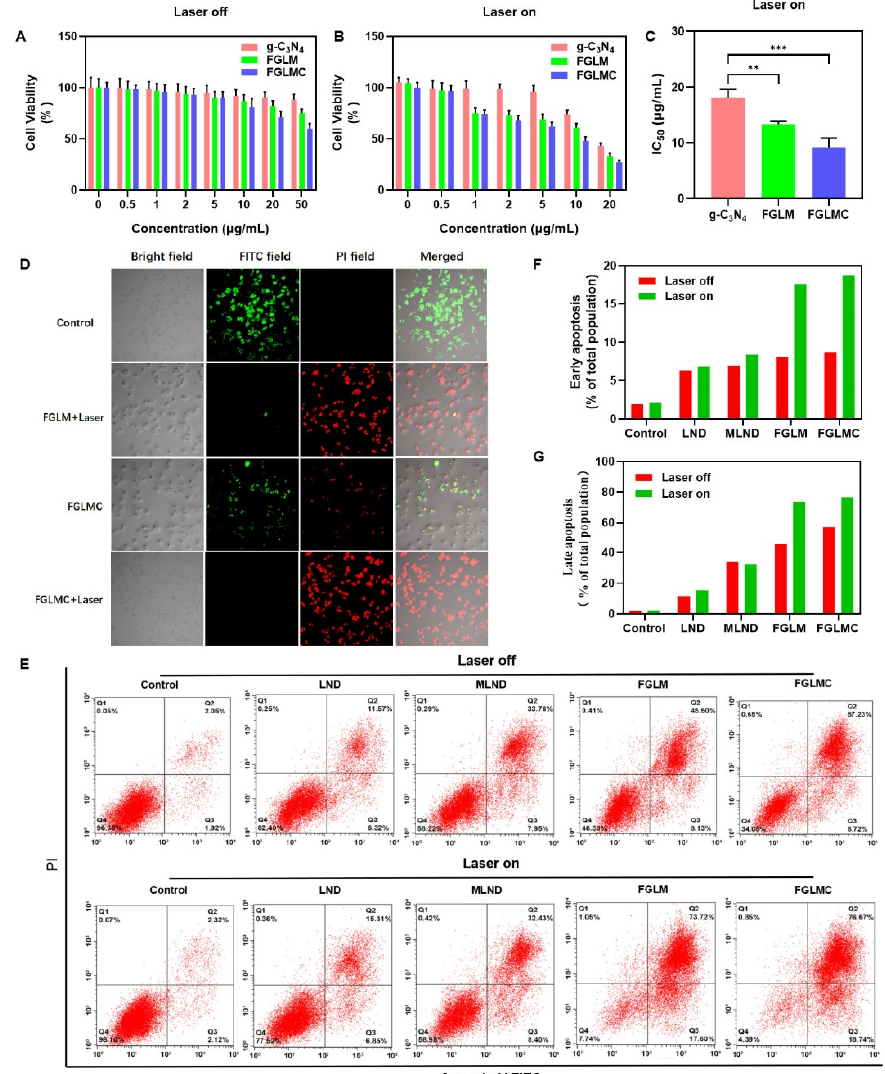
Figure 4. Cytotoxicity of different components in MCF − 7 cells. Viability of cells in response to formulation treatment (g − C 3 N 4 , FGLM, and FGLMC ) without ( A ) or with ( B ) light irradiation (660 nm, 100 mW cm − 2 , 5 min) ( n = 3). ( C ) IC 50 value of three components in the presence of laser treatment (** p < 0.005, *** p < 0.0001). ( D ) Calcein-AM/PI double staining of MCF − 7 cells treated with different formulations with or without laser irradiation (Scale bars represent 100 μ m). ( E ) Annexin V/PI double staining of MCF-7 cells treated with different formulations with or without laser irradiation (Scale bars represent 100 μ m). Statistical graph of ( F ) early apoptosis and ( G ) late apoptosis results. Error bars indicate SD ( n = 3).